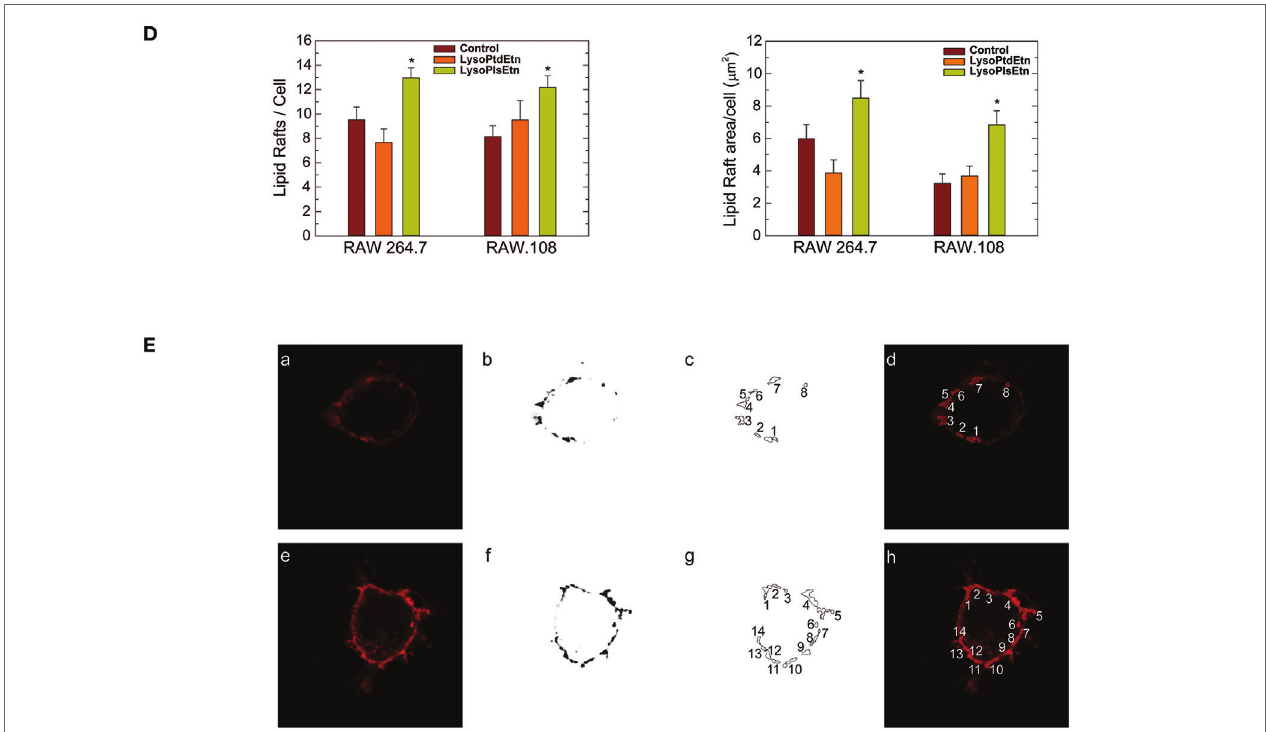
FigUre 6 | Effect of lysoPlsEtn on membrane rafts in RAW264.7 and plasmalogen-deficient RAW.108 cells. The cells were either untreated (brown bars) or treated with 10 µM lysoPlsEtn (orange bars) or 10 µM lysoPtdEtn (yellow bars) for 10 min. Then the cells were incubated for 30 min in the absence (a,B) or presence (c,D) of opsonized latex beads (10 particles per cell), stained with fluorescent cholera toxin (CT-B), and analyzed for lipid raft content by confocal microscopy (red color, middle columns). DAPI (1 µg/ml) was used to mark the nuclei (blue; left columns). Nomarski images are also shown (right columns). The average of three independent experiments with 20 determinations each is shown (mean ± SEM) (bottom panel). Original magnification, × 63. *Significantly different ( p < 0.05) from untreated cells. (e) Methodology utilized to quantify lipid rafts: (a,e): native images marked with CT-B [(a) control RAW 264.7; (e) RAW 264.7 + lysoPlsEtn]; (b,f) threshold and transform into an 8-bit binary images with MaxEntropy algorithm of ImageJ Threshold tools software; (c,d,g,h) determination and quantification of lipid raft microdomains being equal or greater than 0.1 µm 2 [(d,h) lipid raft overlay on native